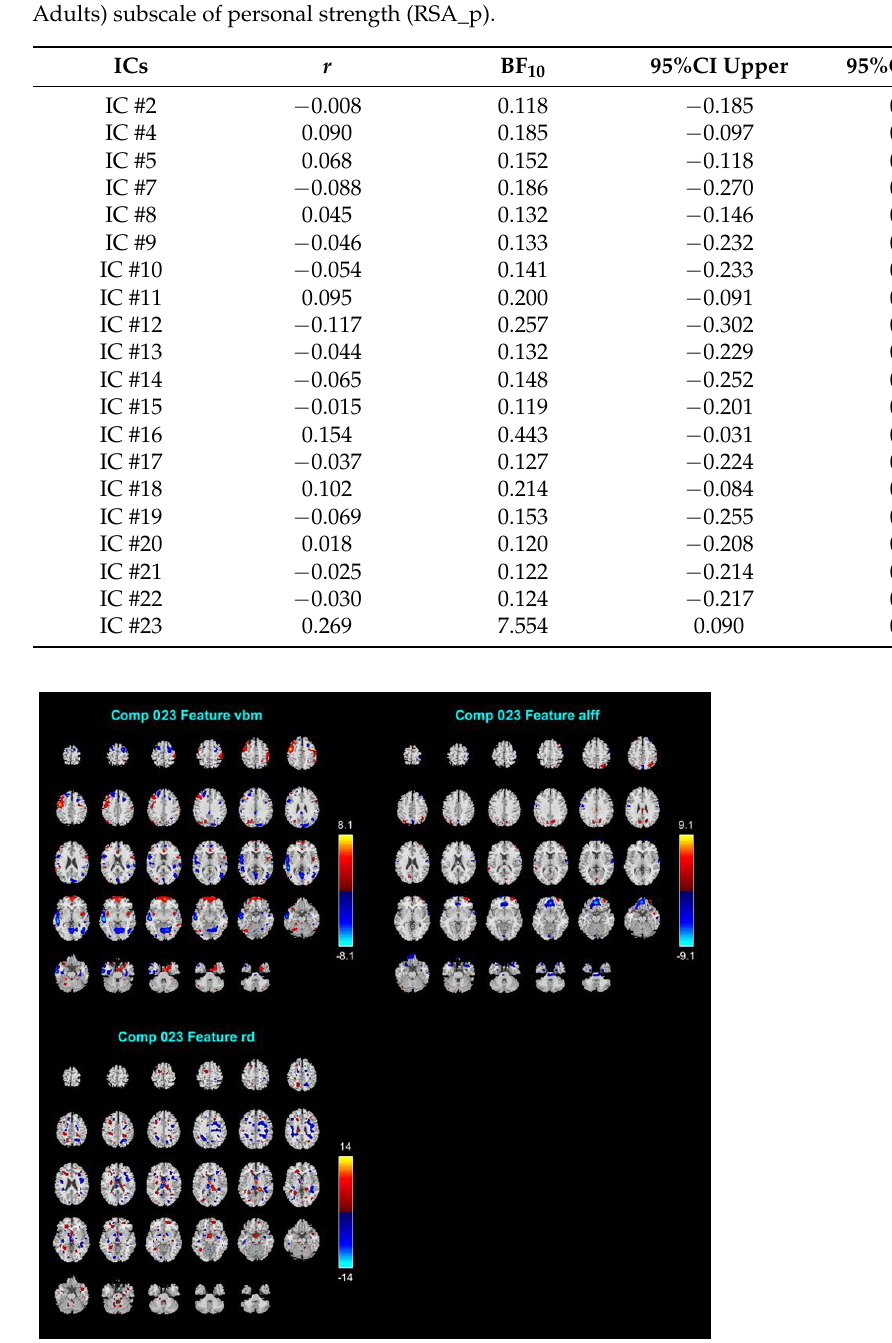
Figure 1. The results of IC #23 in relation to the RSA (Resilience Scale for Adults) subscale of per- sonal strength (RSA_p). The spatial maps shown in this figure were transformed into Z values visualized at |Z| > 2.5. ICs = independent